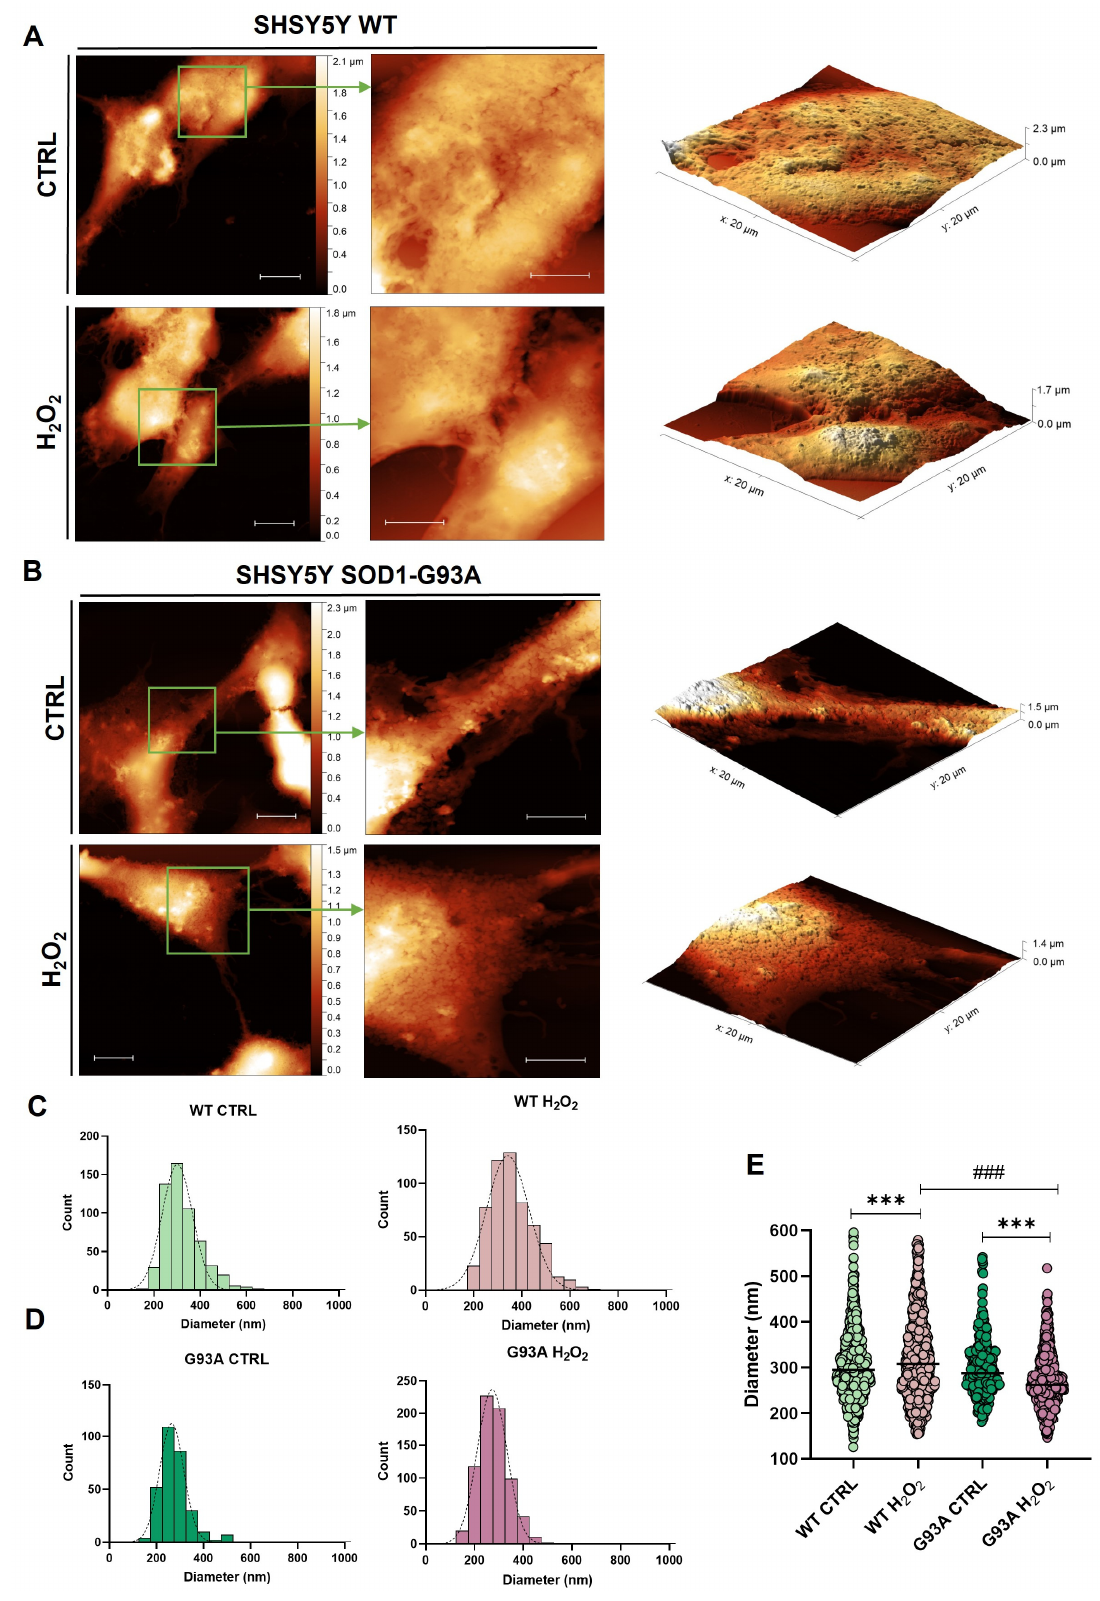
Figure 3. AFM topography, 3D reconstructions, and relative size distributions of SH-SY5Y cells. ( A ) SH-SY5Y WT untreated (CTRL) and treated with H 2 O 2 100 μ M; ( B ) SH-SY5Y SOD1-G93A untreated (CTRL) and treated with H 2 O 2 100 μ M. Scale bars = 10 μ m for the whole cells and 4 μ m for the magnifications. ( C ) Size distributions of budding vesicles from WT SH-SY5Y cells, untreated (left panel, Ntot = 569) or treated with H 2 O 2 (right panel, Ntot = 566). ( D ) Size distributions of budding vesicles from SOD1-G93A SH-SY5Y cells, untreated (left panel, Ntot = 258) or treated with H 2 O 2 (right panel, Ntot = 470). ( E ) Direct comparison of the median diameters of budding vesicles from WT (295.2 ± 3.4 nm for CTRL and 308 ± 3.8 nm for H 2 O 2 ) and SOD1-G93A (287.5 ± 7.7 nm for CTRL and 262.5 ± 3.8 nm for H 2 O 2 ) SH-SY5Y cells. Values represent the mean ± SD; statistical analysis was carried out using one-way ANOVA with Tukey’s multiple comparisons test. *** p < 0.001, when compared with the control group; ### p < 0.001, when compared between WT and G93A groups.